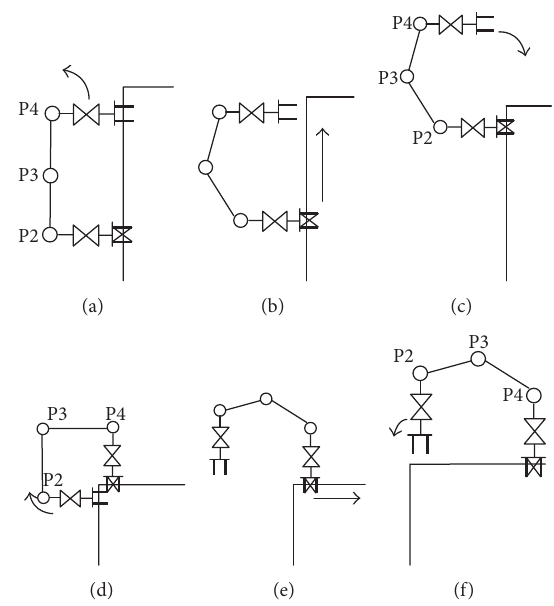
Figure 11: The proposed gait for exterior transition.